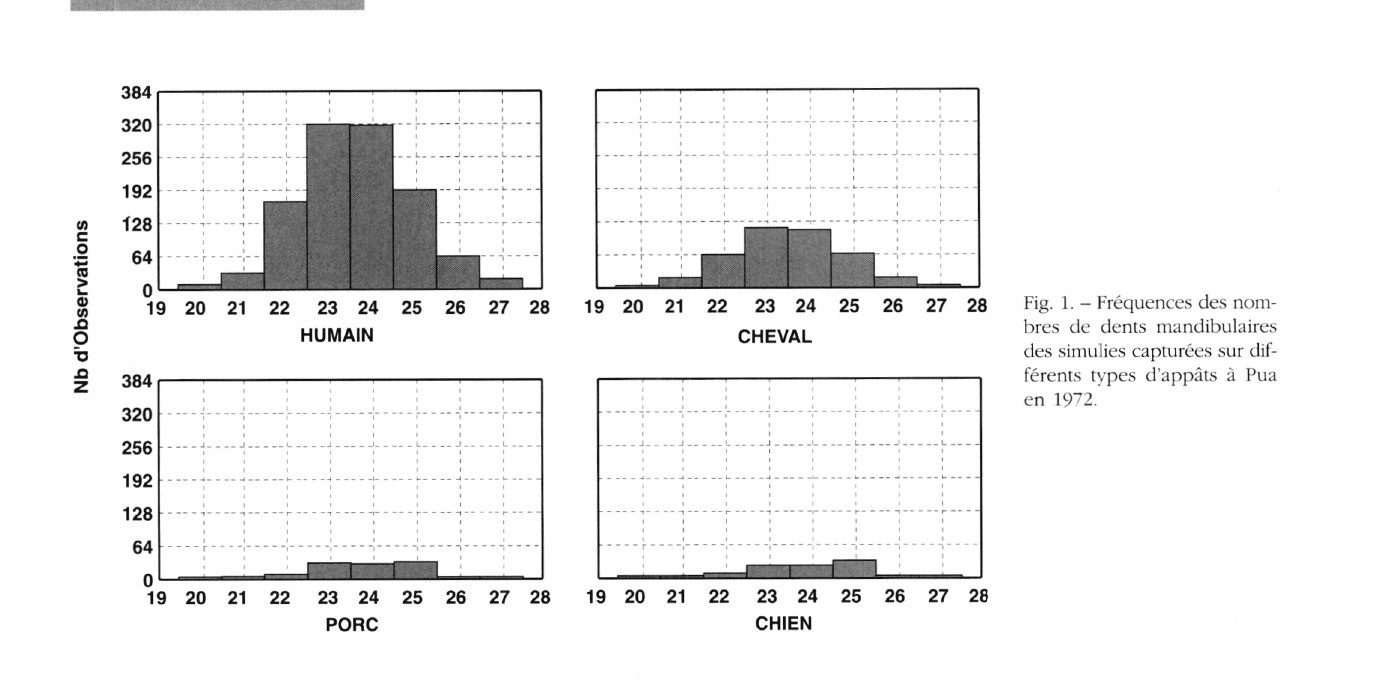
Fig. 1. - Fréquences des nom­ bres de dents mandibulaires des simulies capturées sur dif­ férents types d’appâts à Pua en